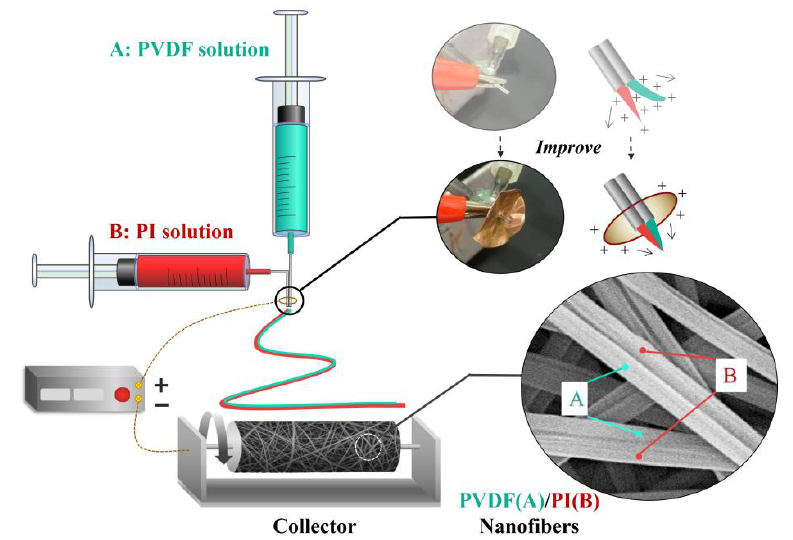
Figure 1. Schematic diagram of side-by-side bicomponent electrospinning equipment.